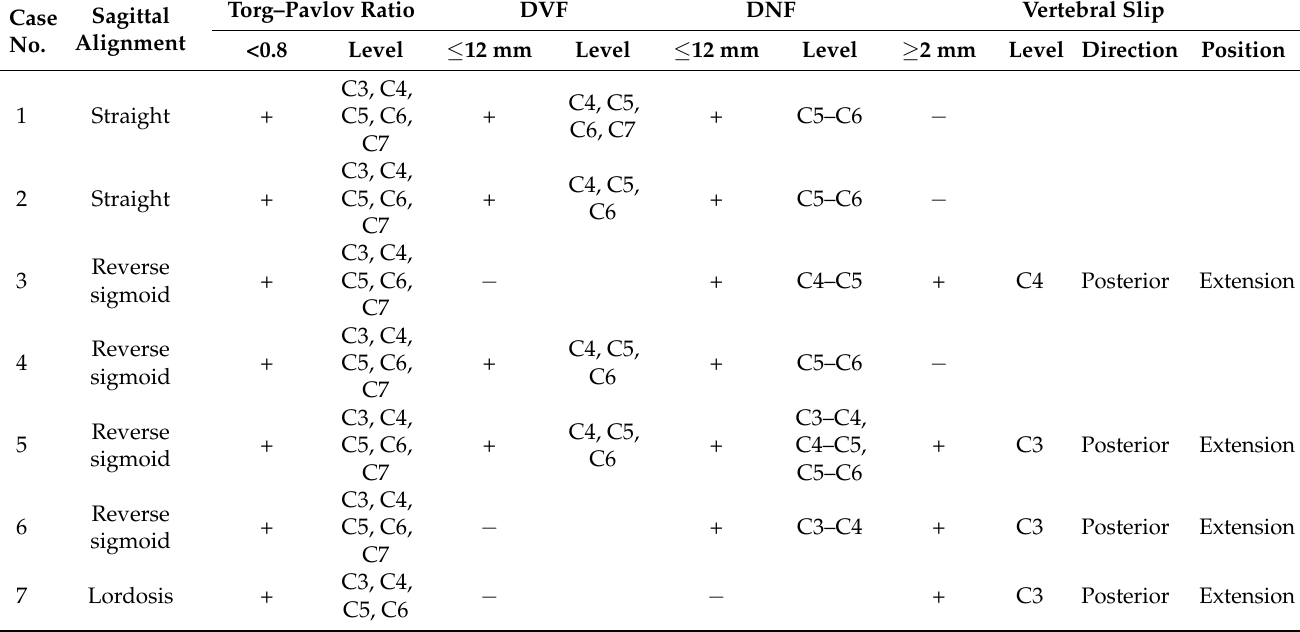
Table 2. Radiographic characteristics of young adult patients with cervical spondylotic myelopathy under age